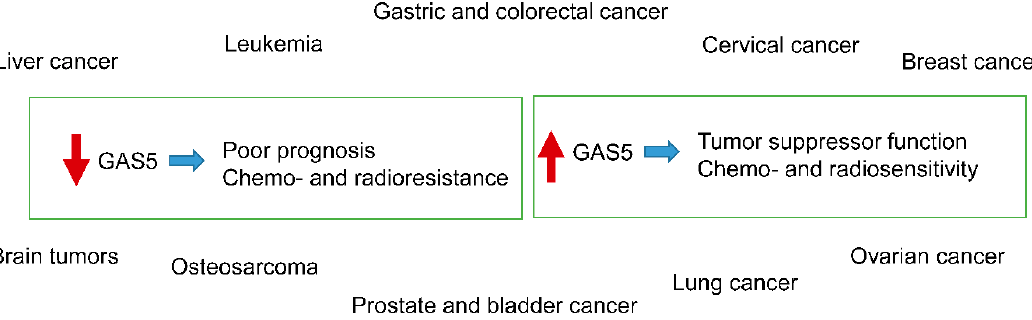
Figure 3. The action of GAS5 on different tumor types. GAS5 down-regulation or mutations are related to poor prognosis, as well as chemo- and radioresistance. On the other hand, the upregulated GAS5 functions as a tumor suppressor and is related to chemo- and radiosensitivity.